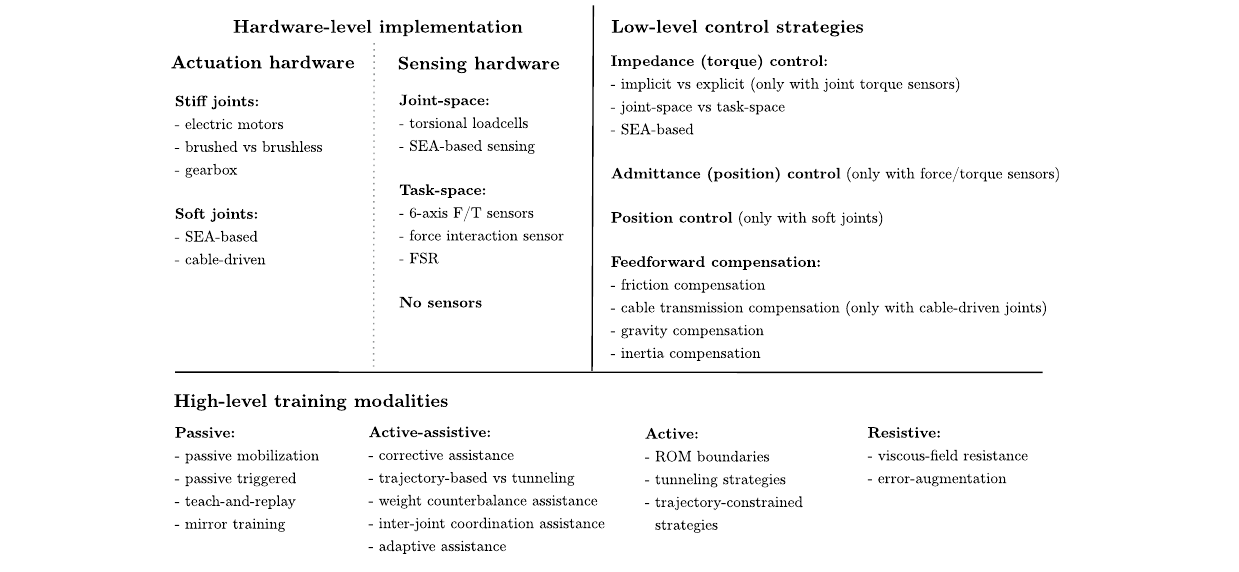
Frontiers in Robotics and AI |